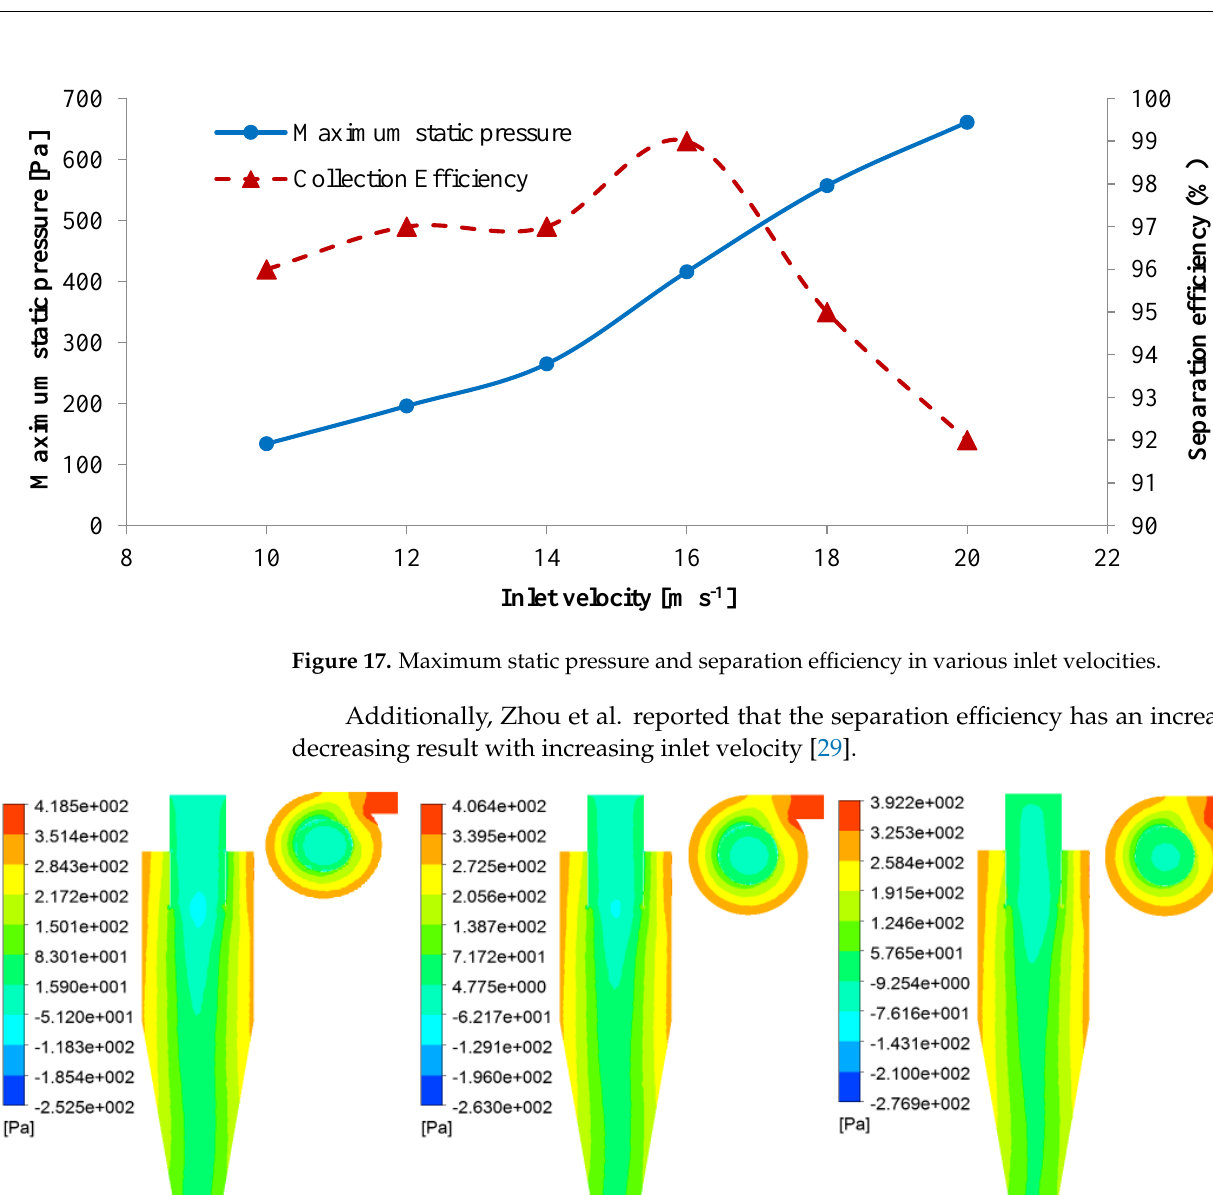
Figure 17. Maximum static pressure and separation efficiency in various inlet velocities.